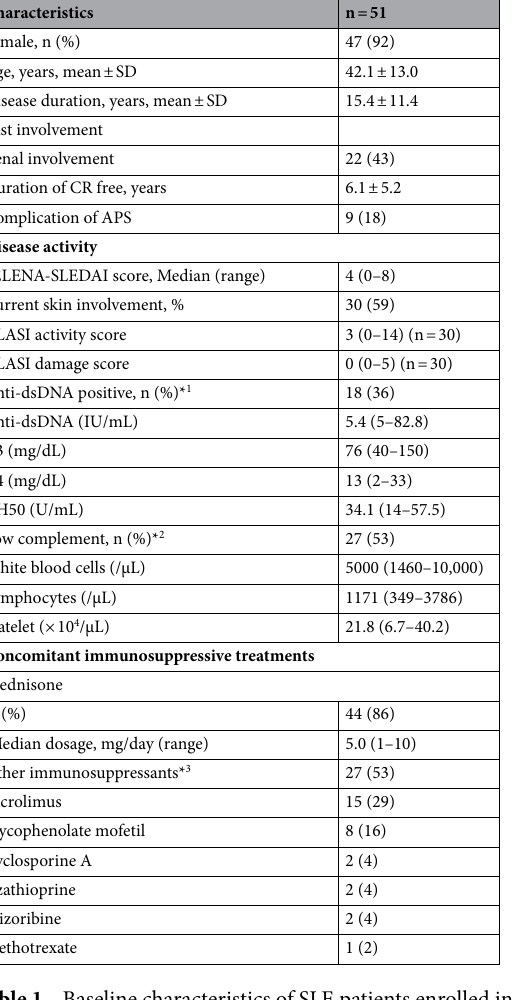
Table 1. Baseline characteristics of SLE patients enrolled in the study (n = 51). * 1 Anti-dsDNA positive is defined as anti-dsDNA titer over 12 IU/mL. * 2 Low complement is defined as C3, C4, and CH50 concentrations less than 68 mg/dL, less 12 mg/dL, and 30 U/mL, respectively. * 3 Three patients received